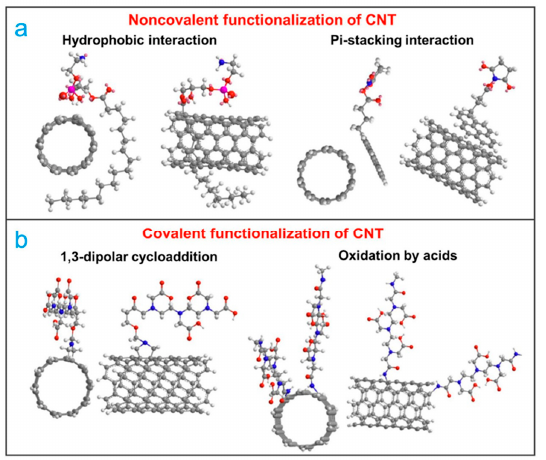
Figure 2. Functionalization modes of CNTs surface. ( a ) noncovalent functionalization and ( b ) covalent functionalization on the CNTs surface [61].